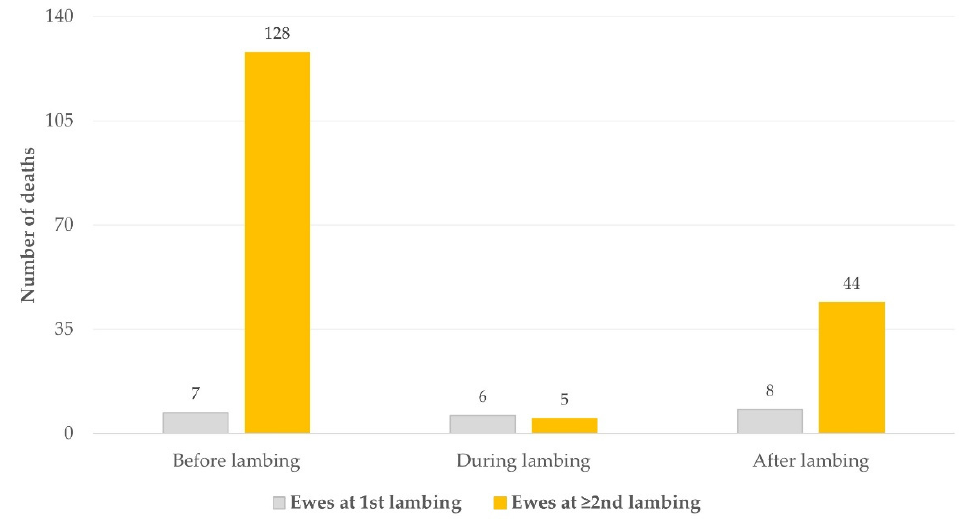
Figure 3. Frequency of peri-parturient deaths in relation to the time of lambing and the age of the ewes that died, during a two-year study in 60 sheep flocks in Greece (gray: ewes at 1st lambing; orange: ewes at ≥ 2nd lambing). The duration of the period before lambing was 10 days; at lambing, 1 day; after lambing, 7 days.